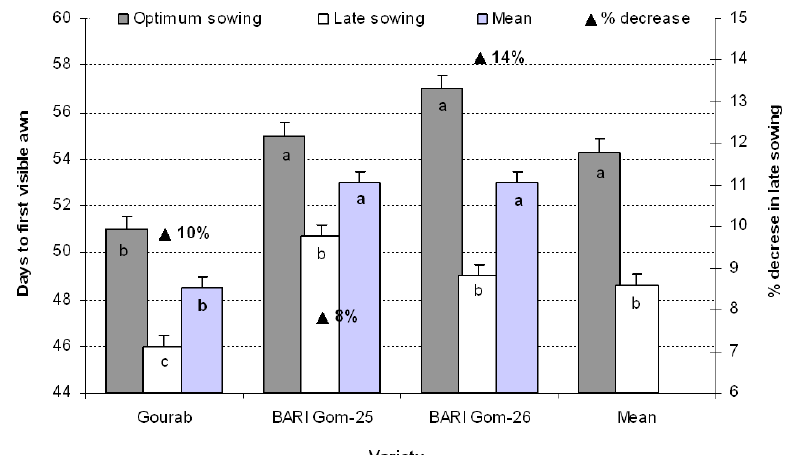
Fig. 4. Days passed to the first visible awn of 3 wheat varieties when sown under op- timum and very late conditions. Mean (±SD) was calculated from three replicates for each treatment. Bars with different letters are significantly different at p ≤0.05